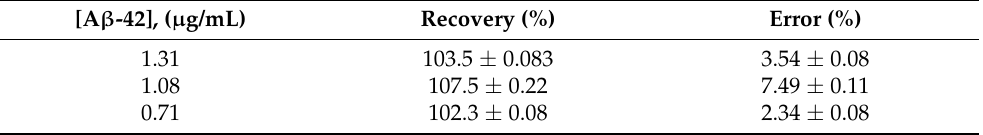
Table 2. Analytical application of the sensor in spiked serum samples in serum pH